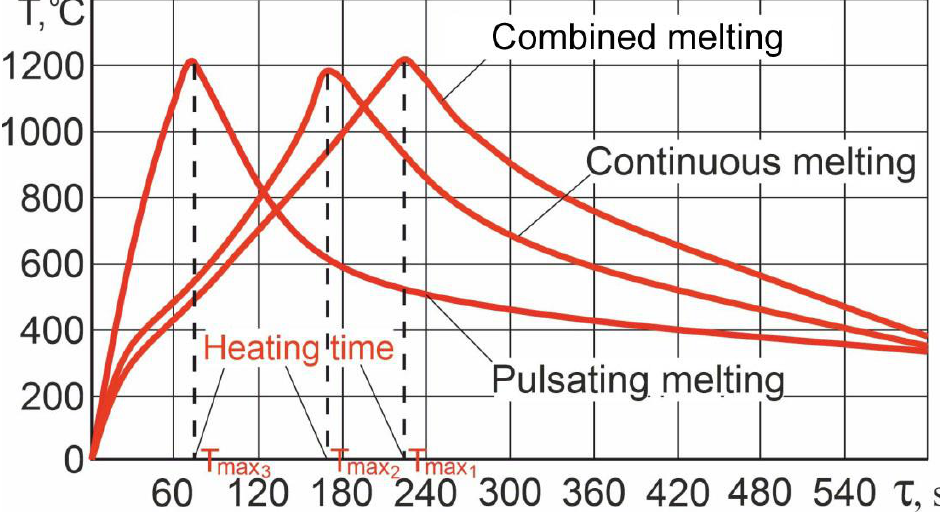
Figure 2. Thermal cycles using different methods of flashing contact welding of rails.